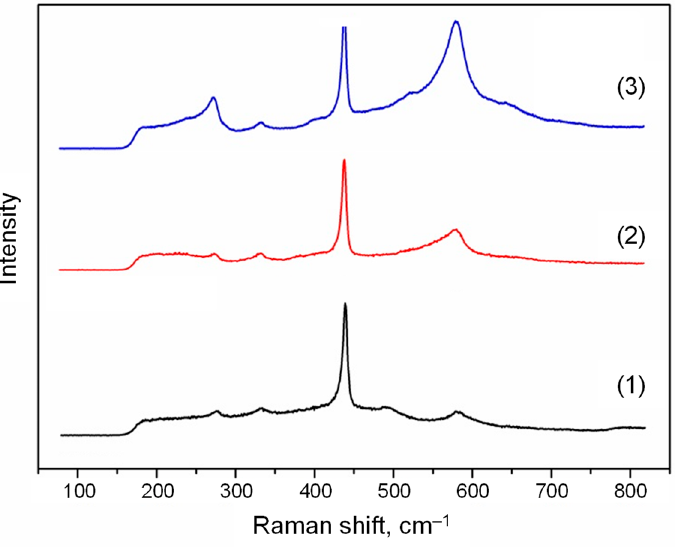
Figure 6. The Raman spectra of the ZnO structures obtained by the PECVD method at the various zinc source temperatures: (1) 370 °C, (2) 420 °C, (3) 470 °C.